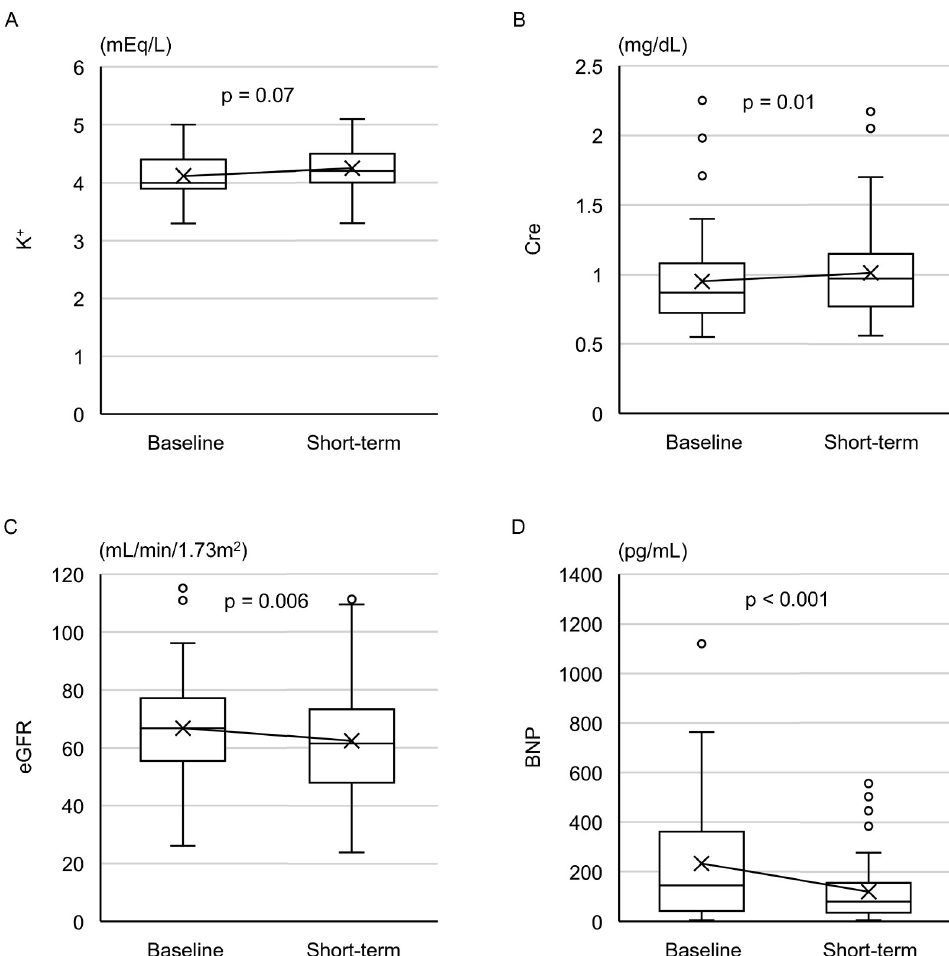
test, and BNP level was compared using the Wilcoxon signed-rank test. K + , serum potassium; Cre, serum creatinine; eGFR, estimated glomerular filtration rate; BNP, brain natriuretic